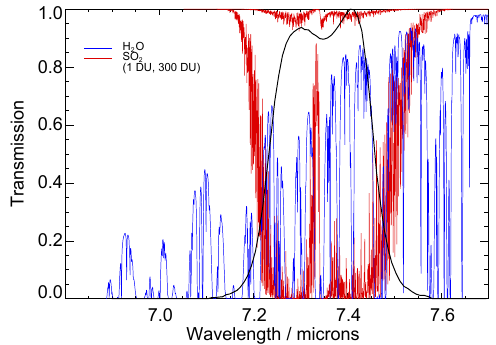
Figure 1. Transmission spectra of H 2 O and SO 2 simulated from Southern Hemisphere mid-latitude water ECMWF ERA-Interim background vapour profile using the RFM (see text). The SO 2 spec- tra were simulated using triangular profiles to represent column amounts of 1 and 300DU, as used in the forward model.